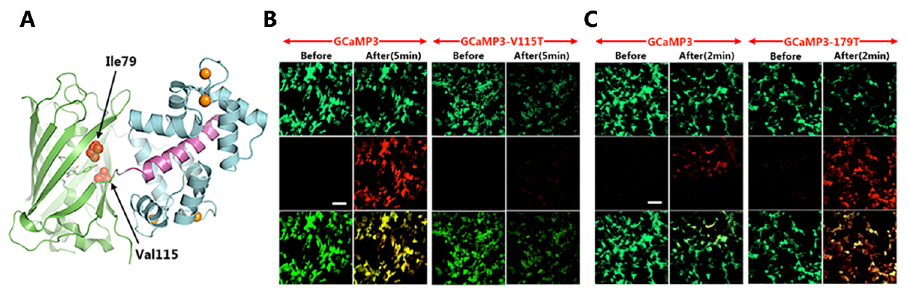
Fig 3. The amino acid residues critical for green-to-red photoconversion. (A) A 3-D crystal structure of GCaMP3 protein illustrating GFP backbone in green, calmodulin in cyan and myosin M13 in purple. The spatial positions of amino acid Ile79 and Val115 are highlighted by arrows. (B-C) Control and mutant GCaMP3s were expressed in HEK293 cells. Green (top), red (middle) and merged (bottom) fluorescent micrographs were taken before and after the cells were exposed to blue light (mercury arc light passed through a FITC filter) for either 5 minutes (B) or 2 minutes (C) . Note that V115T results in a loss of green-to- red photoconversion, whereas I79T improves efficiency. Scale bar: 20 μ m.